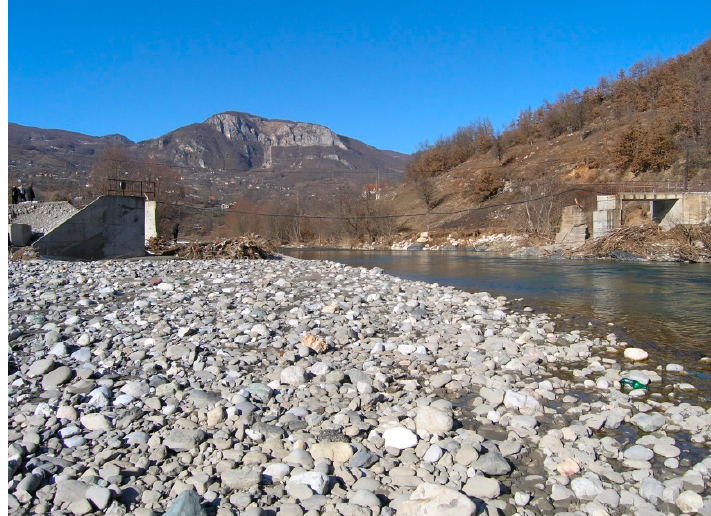
Figure 23. The Seoca bridge after the collapse.